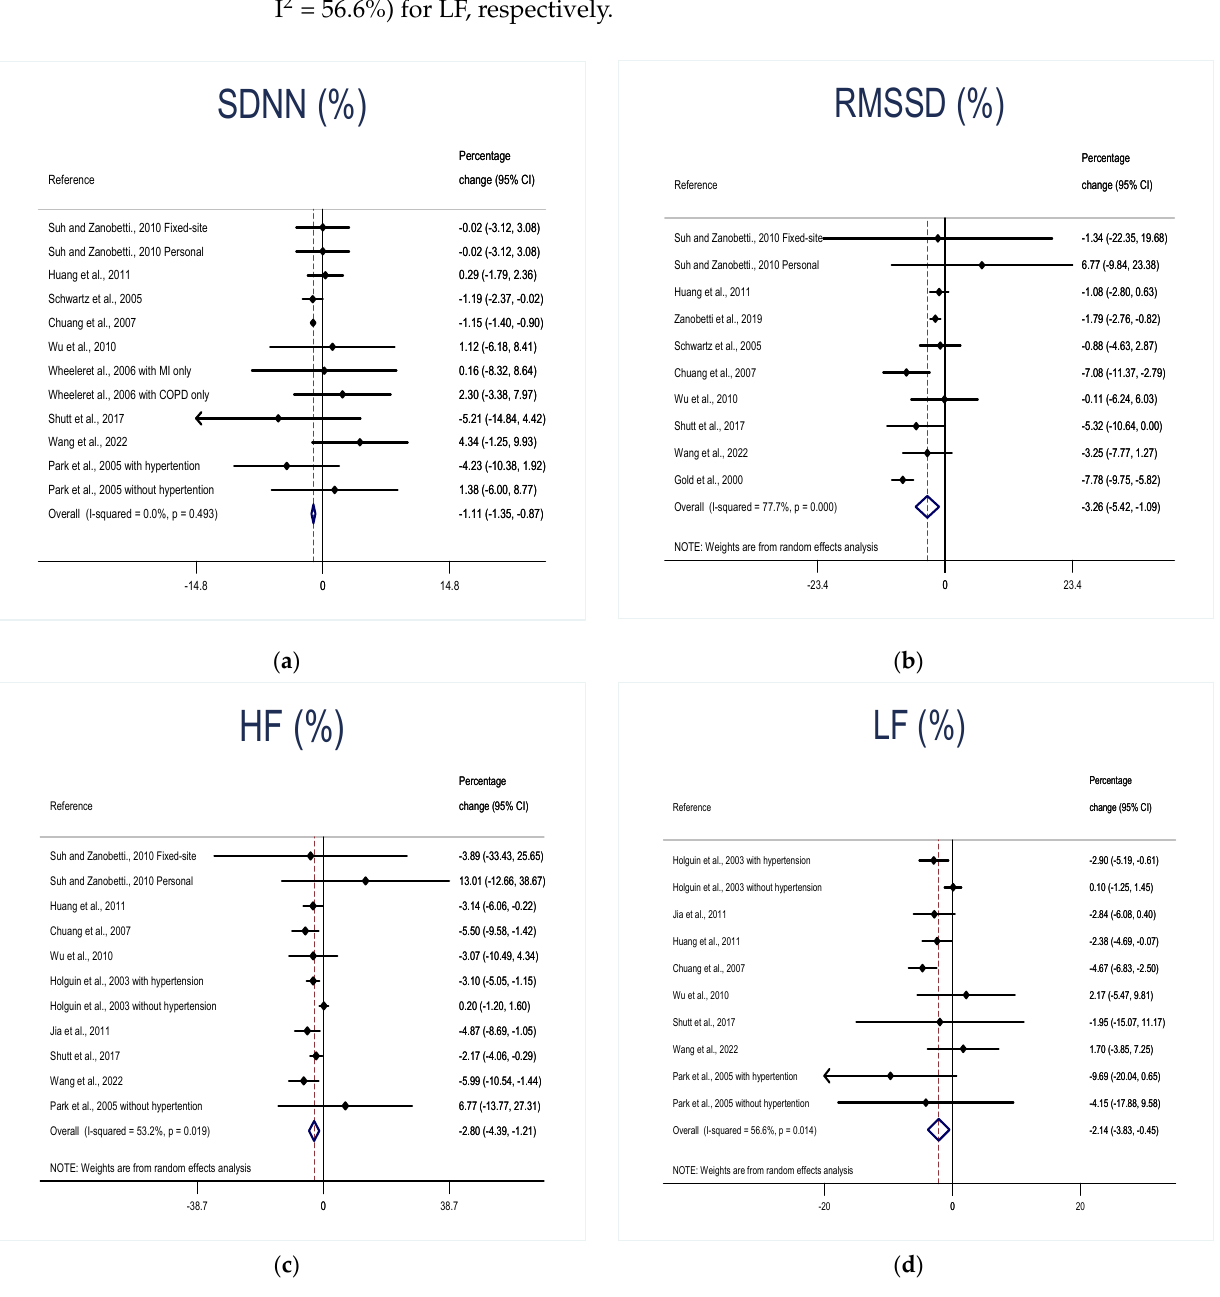
Figure 2. Forest plot of the meta-analysis: per 10 ppb increase in O 3 exposure was associated with pooled percentage changes (%) in HRV indicators: ( a ) SDNN, ( b ) RMSSD, ( c ) HF, and ( d ) LF. MI: myocardial infarction; COPD: chronic obstructive pulmonary disease